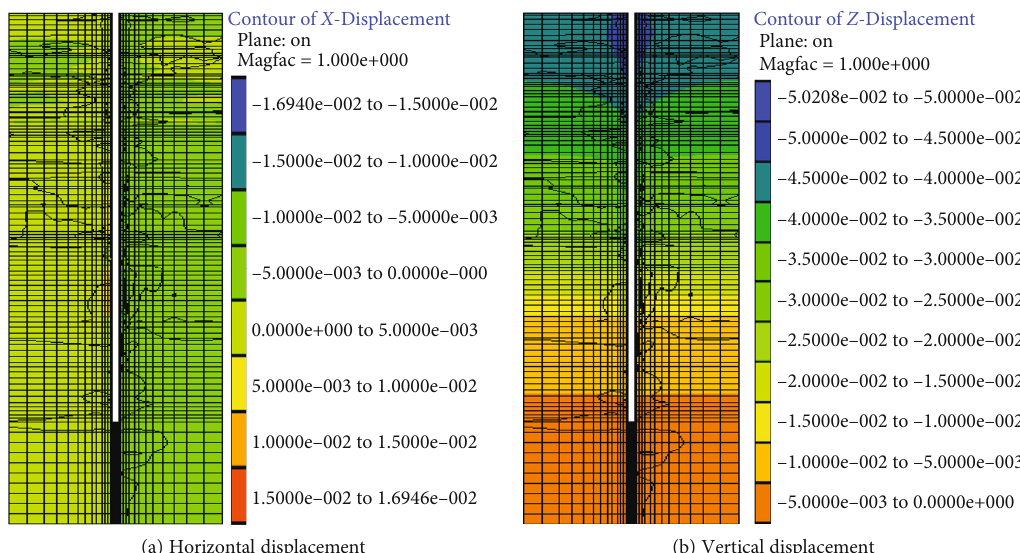
Figure 22: Shaft surrounding rock